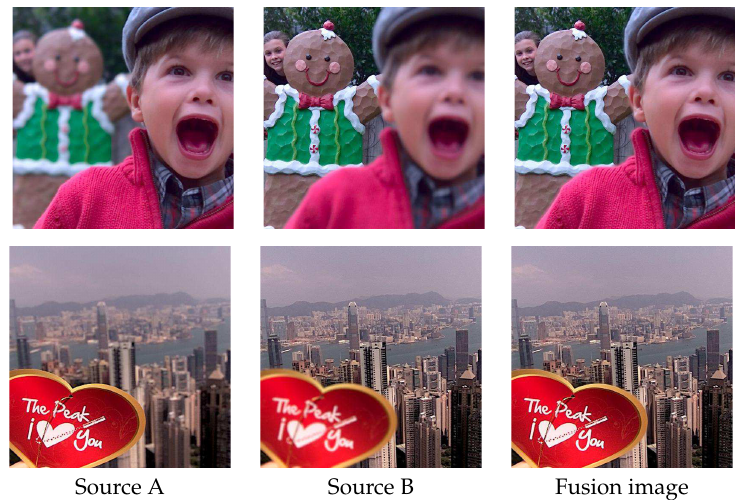
Figure 1. Examples of multi-focus image fusion with two source images. Source A focuses on the foreground and Source B focuses on the background. Fusion image is the fusion result obtained by our